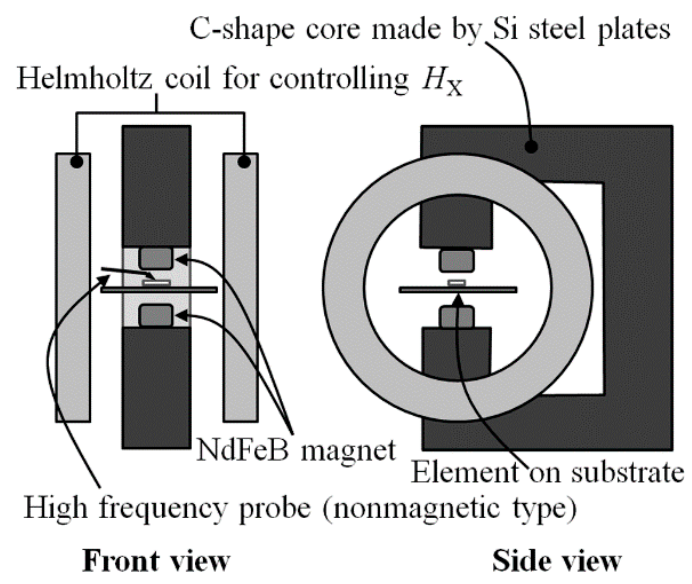
Figure 10. Schematic illustration of measurement apparatus [21]. Figure 11 is a photograph of actual measurement system. A wooden needle was used for feeding a small magnetic particle, with a particle fixing at the tip. The strength of the applied vertical magnetic field was controlled by both the thickness of magnets and the distance of magnets.